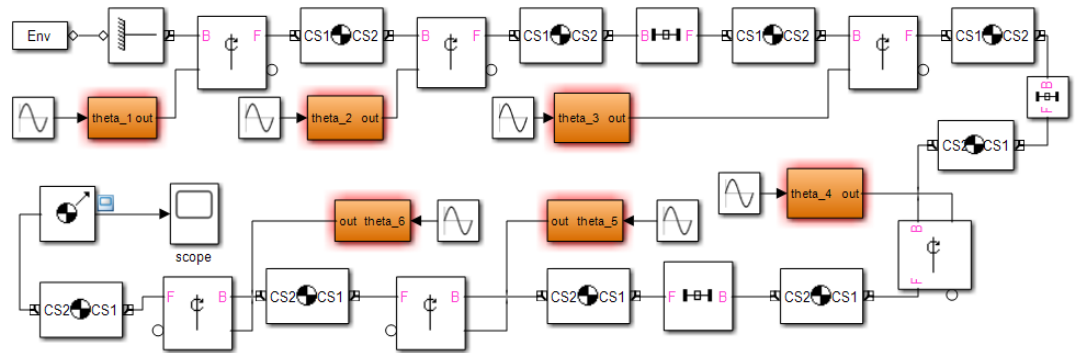
Figure 3. Model drawing of denim-fabric-polishing robot mechanism.